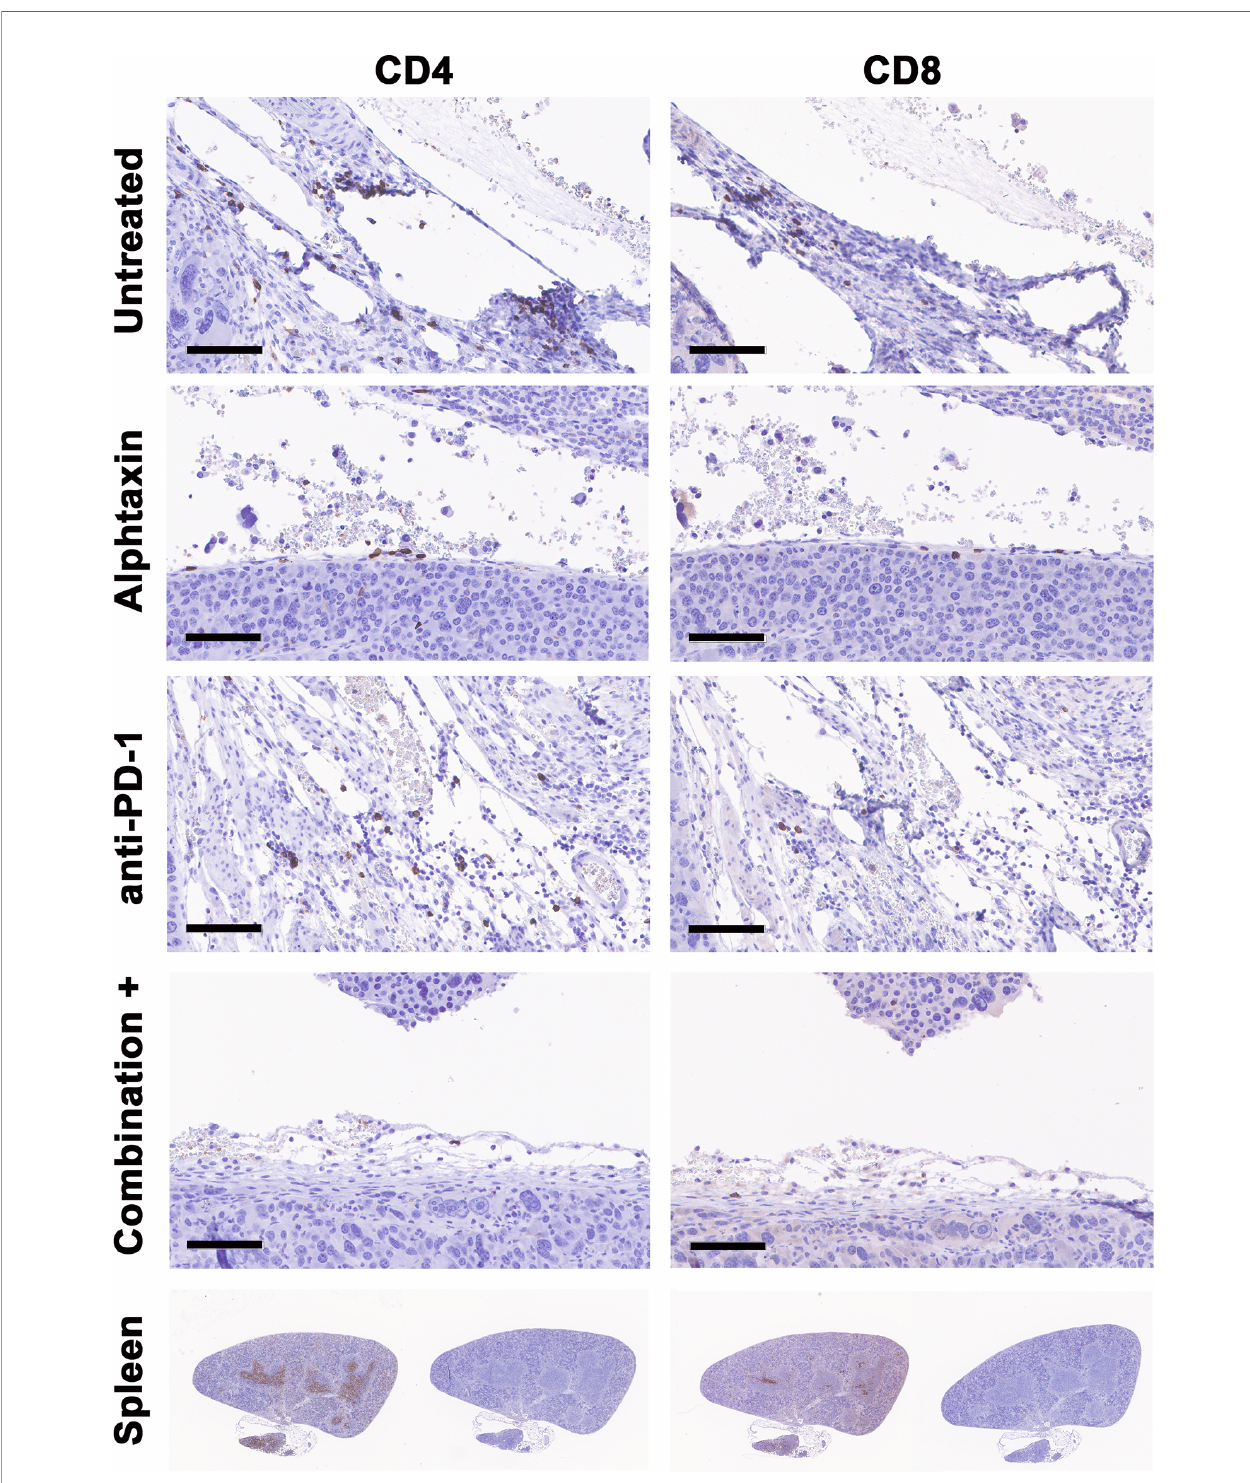
FIGURE 9 | Cryosections from each treatment group stained immunohistochemistry. Representative cryosections depict staining for CD4 + T cells (right panels) and CD8+ T cells (left panels) from approximately the same area of tissue. Bars represent 100µm. Positive (right panels) and negative staining controls (left panels) were performed using cryosections from spleen in which CD4+ and CD8 + T cells are abundant within germinal centers.